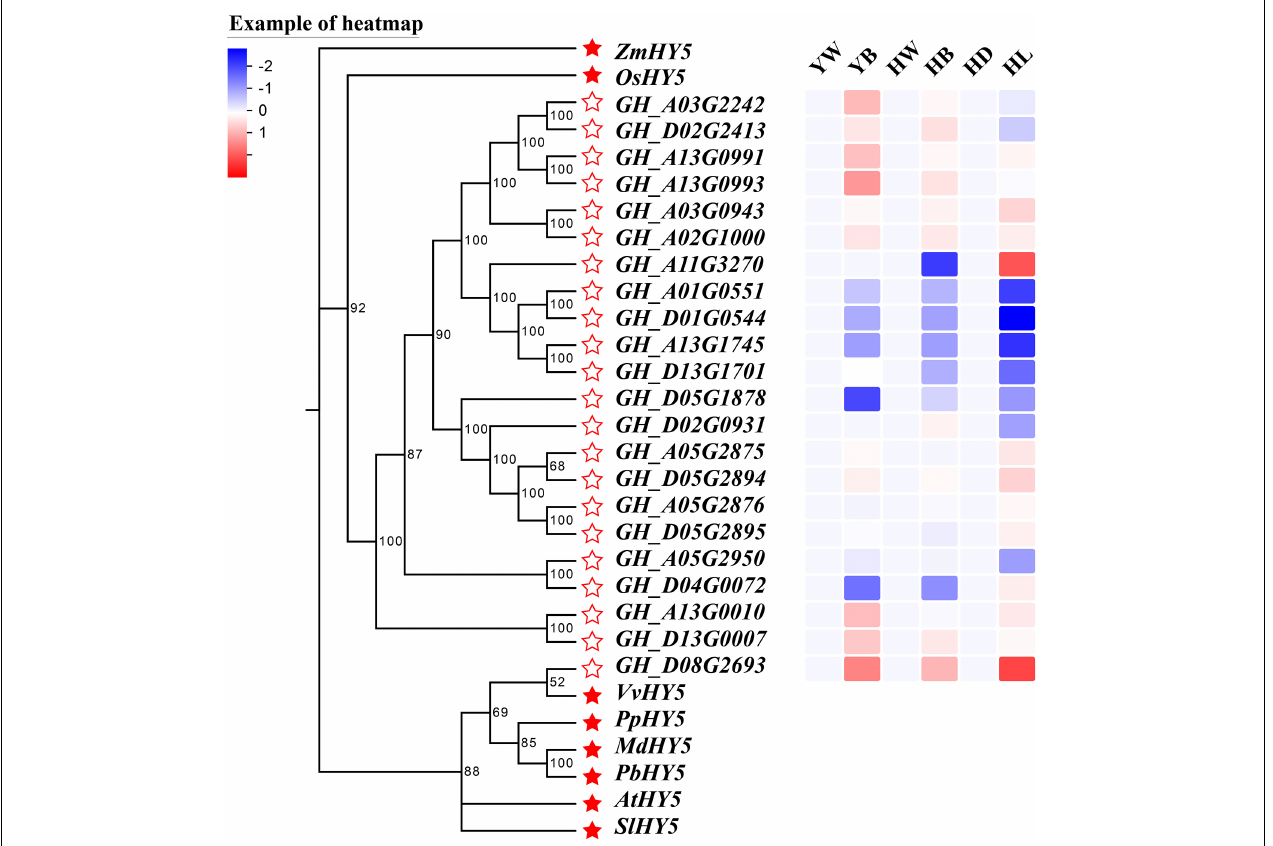
FIGURE 6 | Phylogenetic tree of GhHY5s and the reported HY5s in other plants, and the expression profile of GhHY5s from different tissues under different lighting conditions. The GenBank accession numbers for the HY5 from other plants are AtHY5 (BAA21327.1), SlHY5 (CAB57979.1), OsHY5 (BAD35451.1), MdHY5 (BAM71071.1), VvHY5 (AGX85877.1), ZmHY5 (AQK69393.1), PbHY5 (QGP73826.1), and PpHY5 (ONI34365.1). Scale bar indicates the expression level, from low expression (blue) to high expression (red). YW, green leaves of Rs under white light (LED); YB, red leaves of Rs under blue light (white LED light plus blue light); HW, green leaves of R1 under white light (LED); HB, red leaves of R1 under blue light (white LED light plus blue light); HD, white hypocotyls of Huiyuan under dark; HL, red hypocotyls of Huiyuan under light